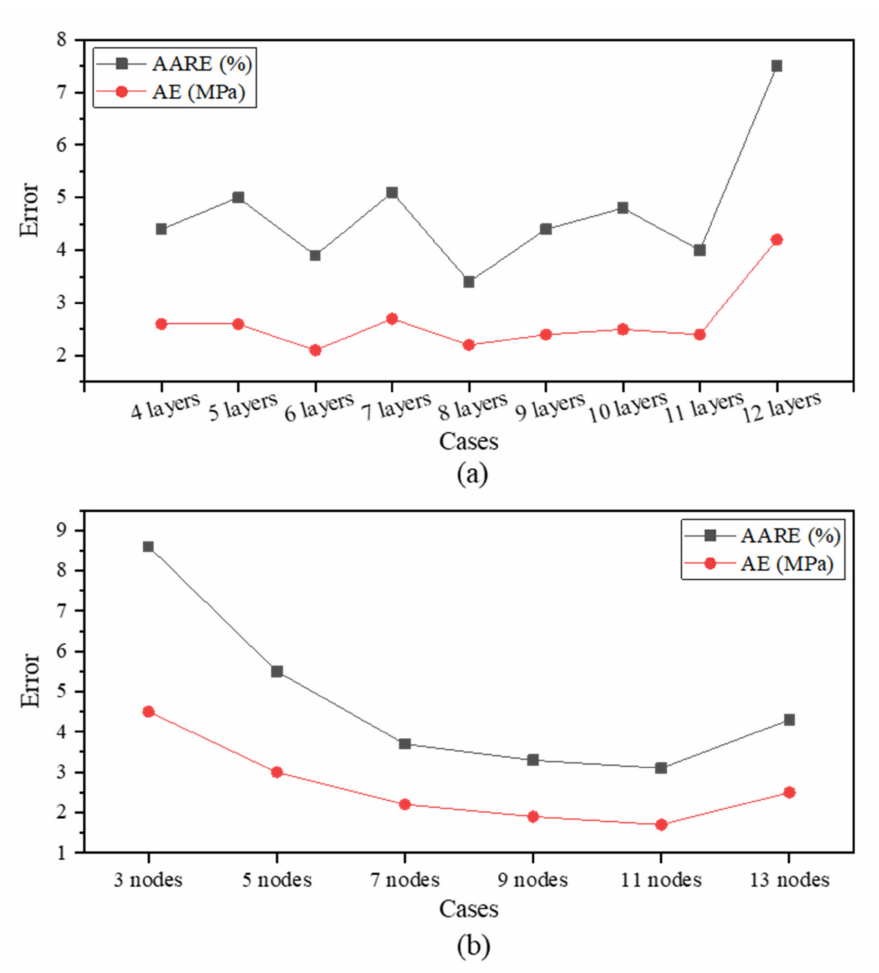
Figure 7. Graphs depicting the results of AARE and AE calculation according to ( a ) the number of hidden layers and ( b ) the number of